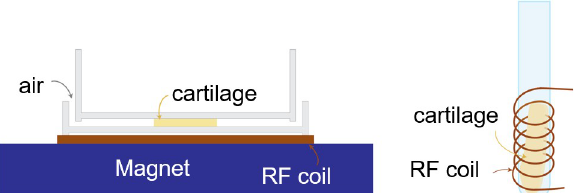
Fig 1. Sample shape and placement for different experiments: a) flat, square sample on top of the magnet, between plastic Petri dishes, b) cylindrical sample in a 5 mm NMR tube in the sensitive area of the NMR coil.